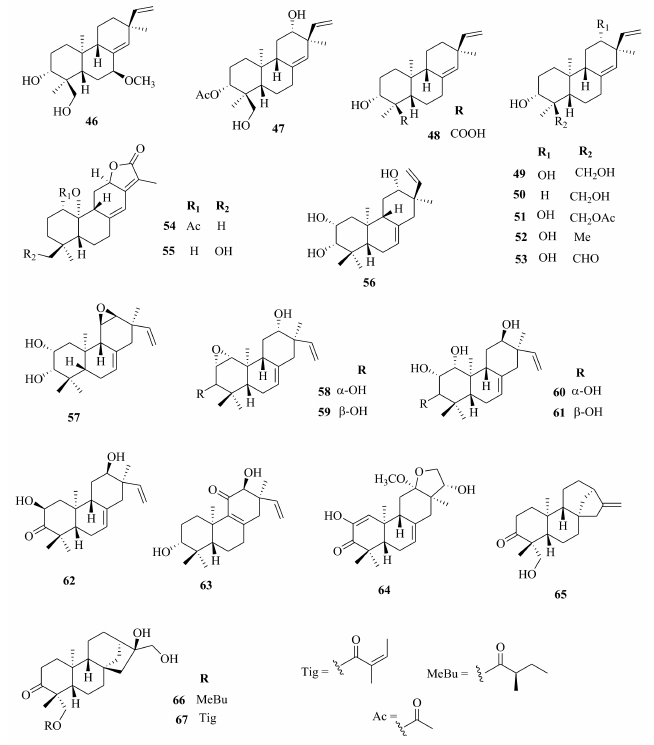
Figure 3. Chemical structures of ent -isopimarane and ent -kaurane diterpenoids.